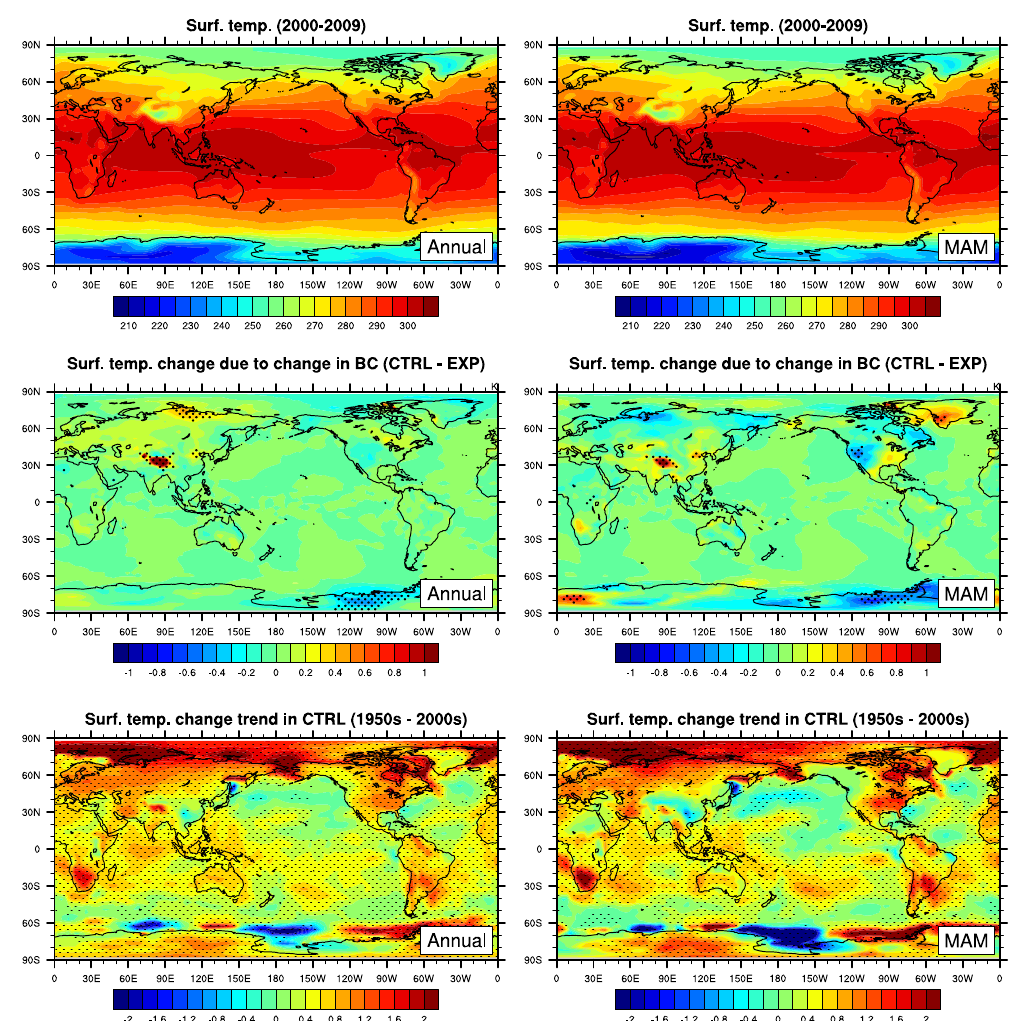
Figure 9. Annual mean (top left) and spring mean (top right) near-surface air temperature (K) during 2000–2009, annual mean (middle left) and spring mean (middle right) near-surface air temperature changes (K) due to BC in snow from the 1950s to 2000s, and annual mean (bottom left) and spring mean (bottom right) near-surface air temperature changes (K) due to all forcing from the 1950s to 2000s. Hatching indicates regions where the results are statistically significant ( p = 0 .